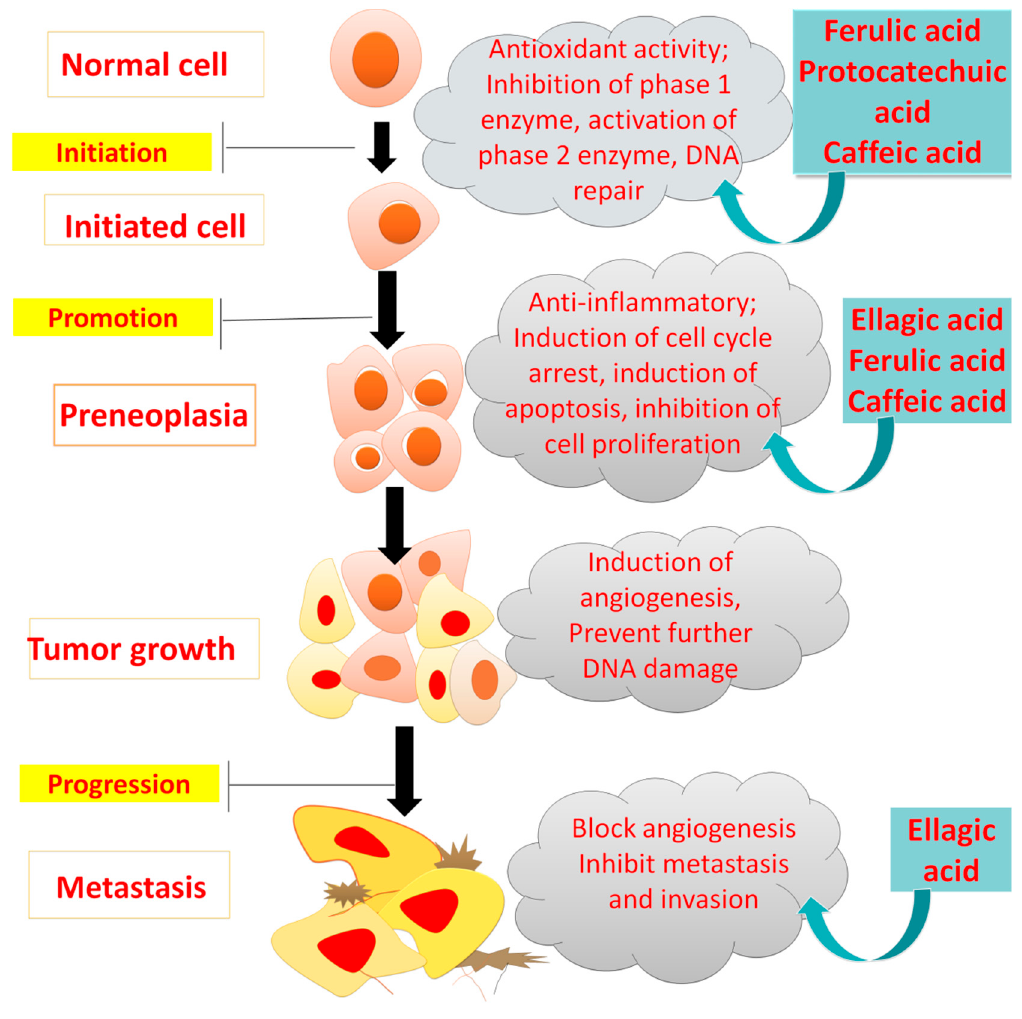
Figure 8. Inhibitory effects of phenolic acid on cancer development.